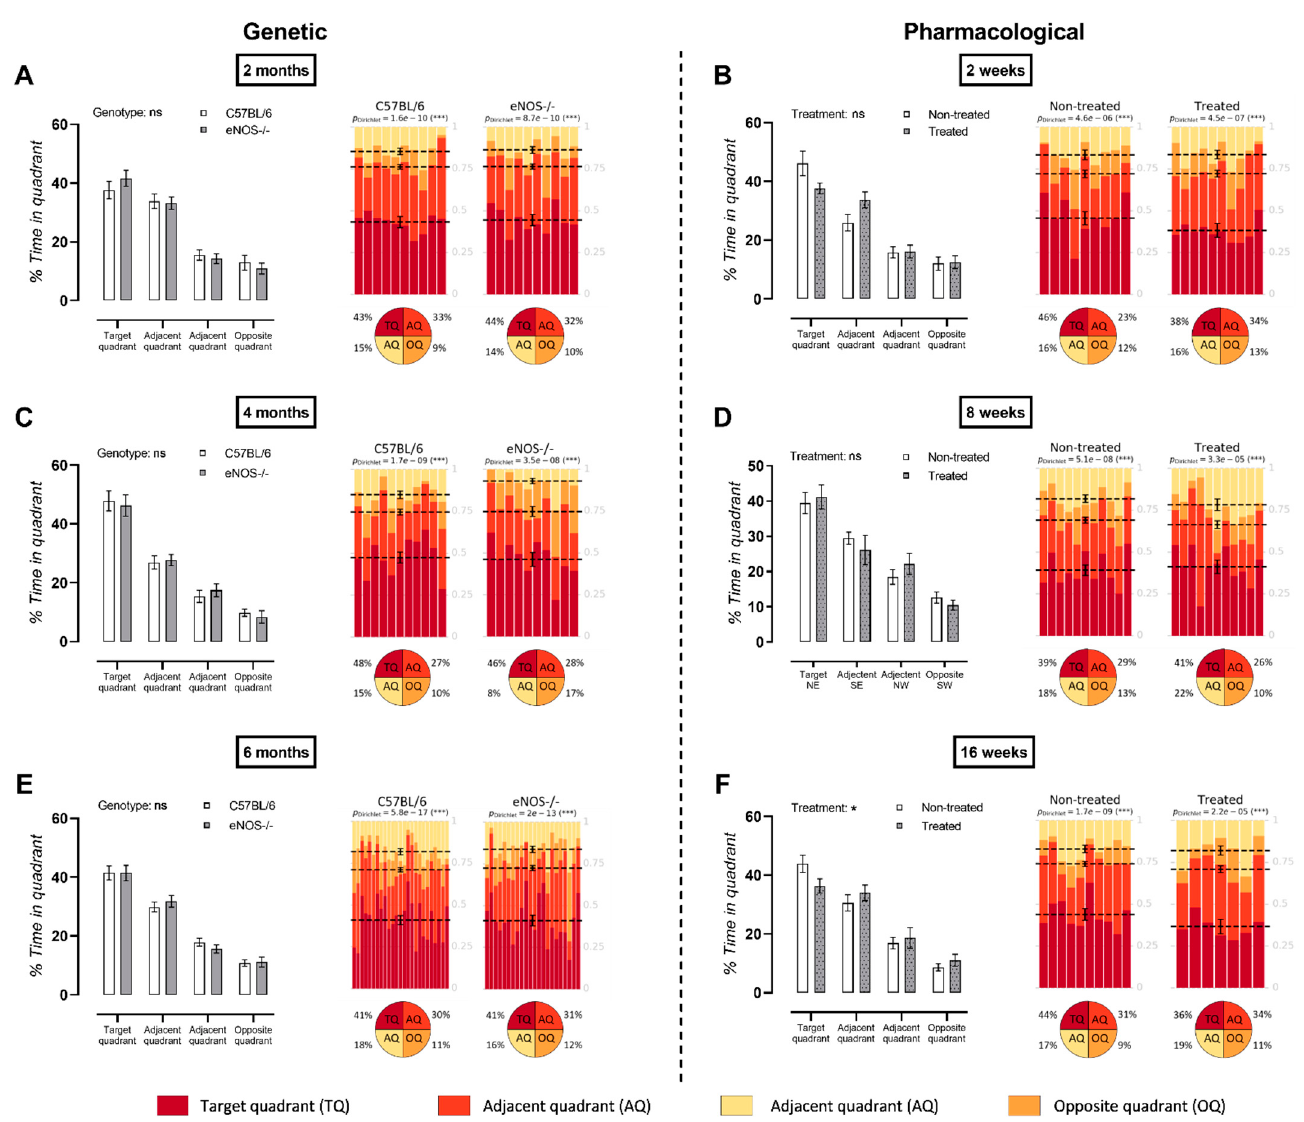
Figure 4. Longitudinal MWM probe trial results. Results for the genetic NO dysfunction murine model are displayed in the left panel with increasing age groups being depicted downward with ( A ) 2 months at the top, ( C ) 4 months in the middle and to ( E ) 6 months at the bottom. Results of the pharmacological NO dysfunction model are shown in the right panel with increasing treatment times being depicted downward from ( B ) 2 weeks at the top, ( D ) 4 weeks in the middle, and ( F ) 16 weeks at the bottom. Factorial ANOVA for the factors genotype/treatment, * p < 0.05, *** p < 0.002. Data are presented as mean ± SEM. Heatmaps represent statistical analysis via Dirichlet distributions as described earlier [25]. Each column represents the probe trial performance of an individual animal, and each color represents a different quadrant of the MWM. Mean values for the fraction of time spent in each quadrant are represented by a dotted line with respective error bars for the SEM. Average percentages of time spent by the animals in the MWM are indicated in the pie chart beneath the heatmap of each tested group. Respective Dirichlet p -values are indicated at the top of each heatmap.